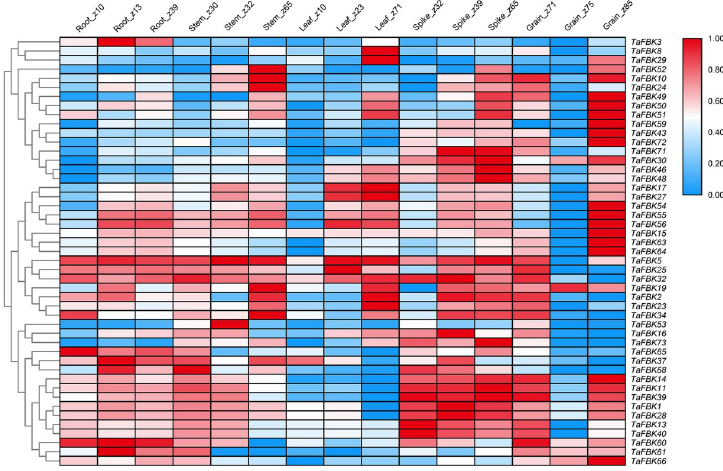
Fig 2. Heat map showing digital expression profiles of FBK genes in various tissues and at different developmental stages of wheat based on FPKM values. The color key represents FPKM values. Identity of tissue samples and developmental stages (Zadoks scale) are provided at the top of each